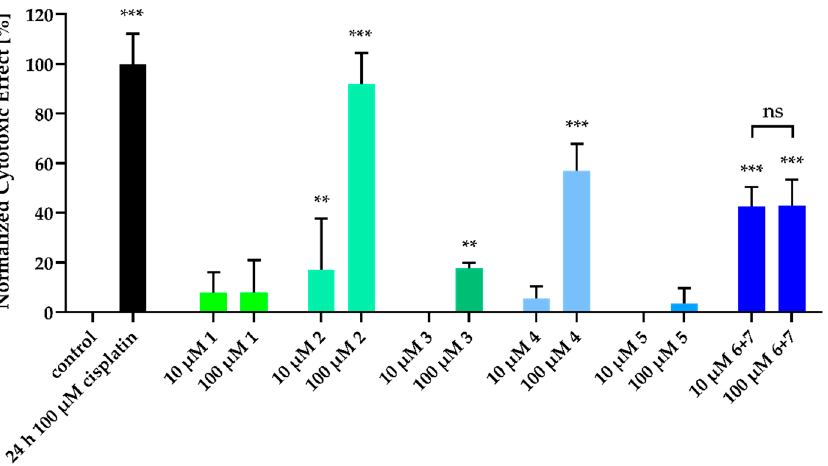
Figure 6. Cytotoxic activity of compounds of Melicope barbigera. A2780 cells were incubated with the compounds in the indicated concentrations for 72 h. Cell culture medium was added as a control for vehicle treated cells (“control”). A 24 h treatment with 100 µM cisplatin served as positive control. Data are the mean ± SD, n ≥ 3. Statistical analysis to compare the effects of compound and control was performed using t-test. For normalization, the value of the vehicle control was set to 0% and the 24 h 100 µM cisplatin control was set to 100%. Levels of significance: ns ( p > 0.05); ** ( p ≤ 0.01); *** ( p ≤ 0.001) Effect bars without annotation are ns. Representative fluorescent imaging pictures for compounds with significant effects are shown in supplemental Figure S32.